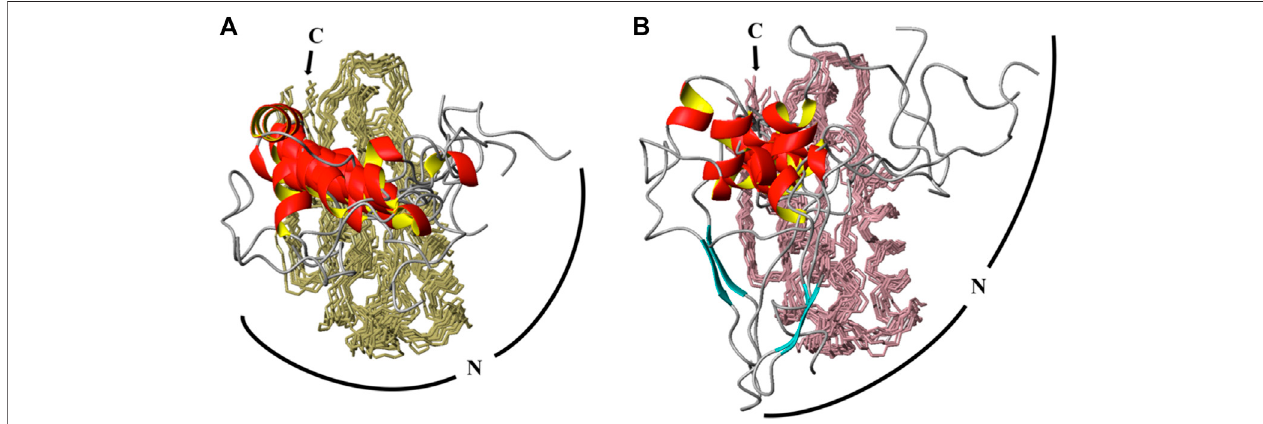
FIGURE 4 | CS-Rosetta calculated ensembles of T. maritima P protein at high (466 μ M) and low (153 μ M) concentrations. The same number of chemical shifts arisingfrom the same residues (distributed equally)for identi fi ed monomer and dimer conformations wereincorporated intoCS-Rosettacalculations. Thetop 10scored models of each conformation are overlaid in A (at 466 μ M) and B (at 153 μ M). In both ensembles, 10 structures models are superposed from residue 24 to 117, with backbone regions colored olive ( A ) and light pink ( B ). The N-terminus region (residues 1 – 23) are presented as loop (gray coil-coiled) and ribbons (red helix) segments. The C-terminus (C) is labeled and a curved line of the N-terminus (N) is included to highlight the predicted amplitudes and fl exibility observed in the dimer ( A ) and monomer ( B ) derived